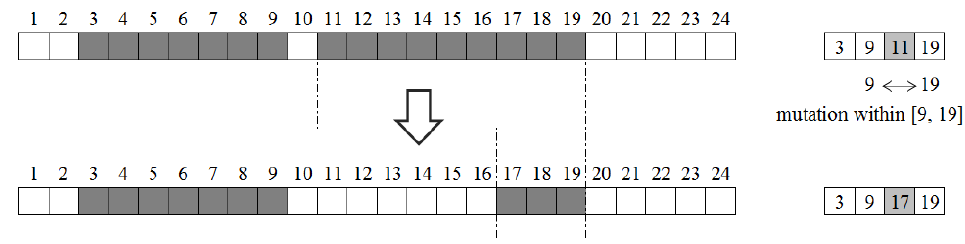
Figure 4. Value of 11 is identified and mutated to 17.